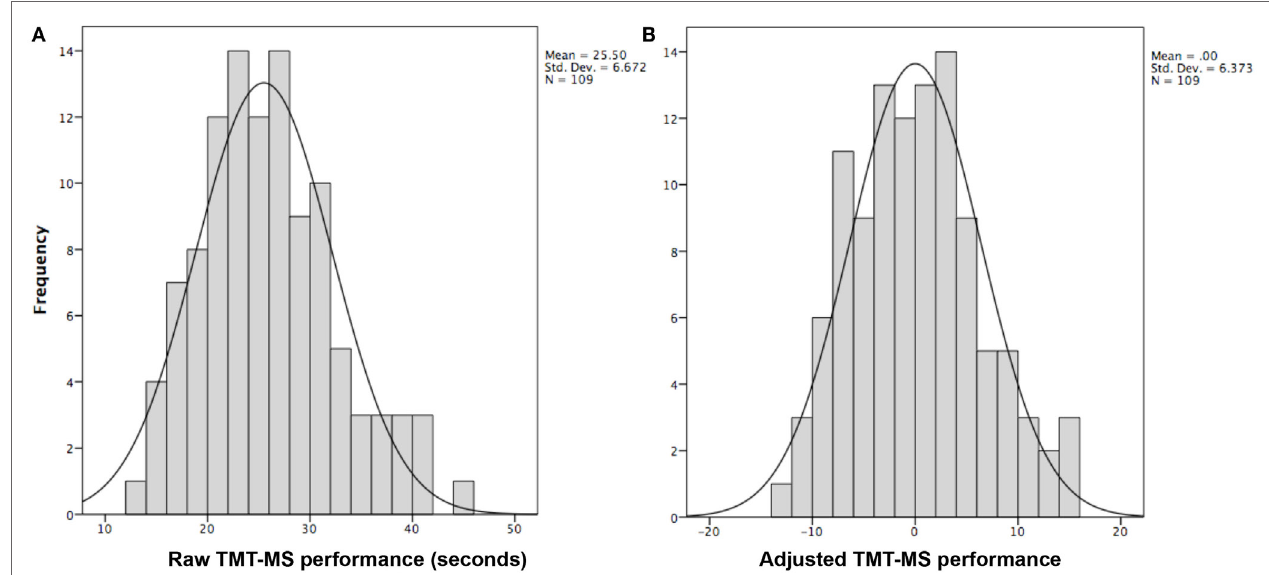
FigUre 1 | histograms showing distribution of TMT-Ms performance . (a) The distribution of the raw TMT-MS performance. (B) The distribution of the adjusted TMT-MS performance after effects of age, gender, handedness, and BDI scores were regressed out of the raw